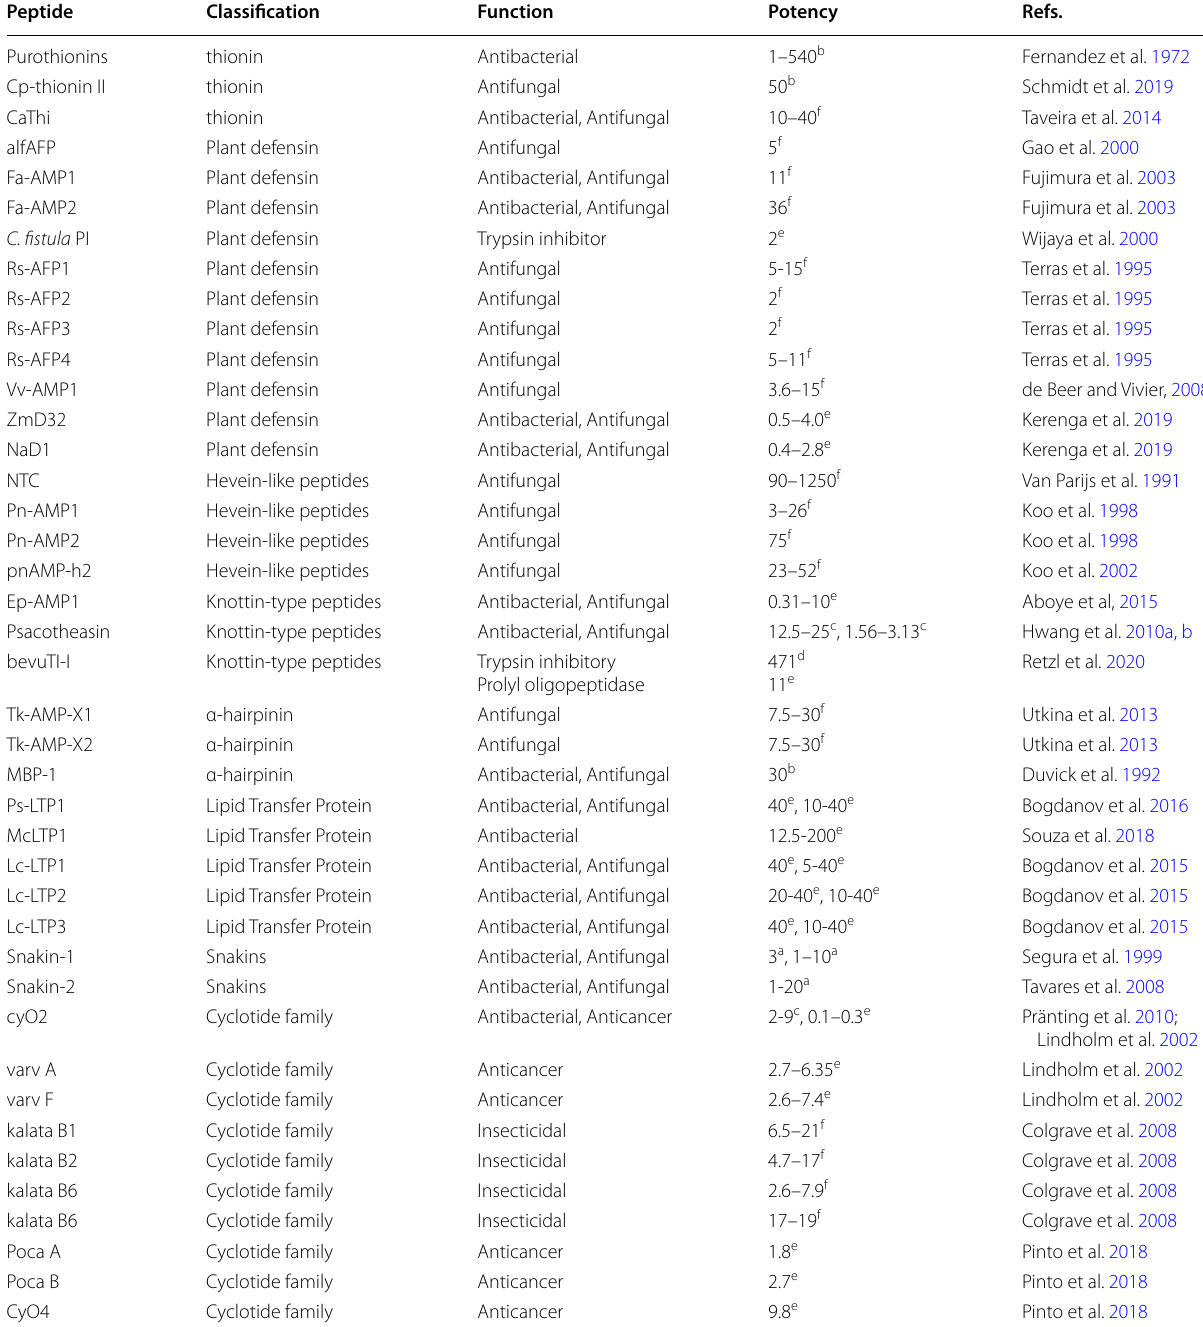
Table 1 Summary of some common plant antimicrobial peptides about their classification and